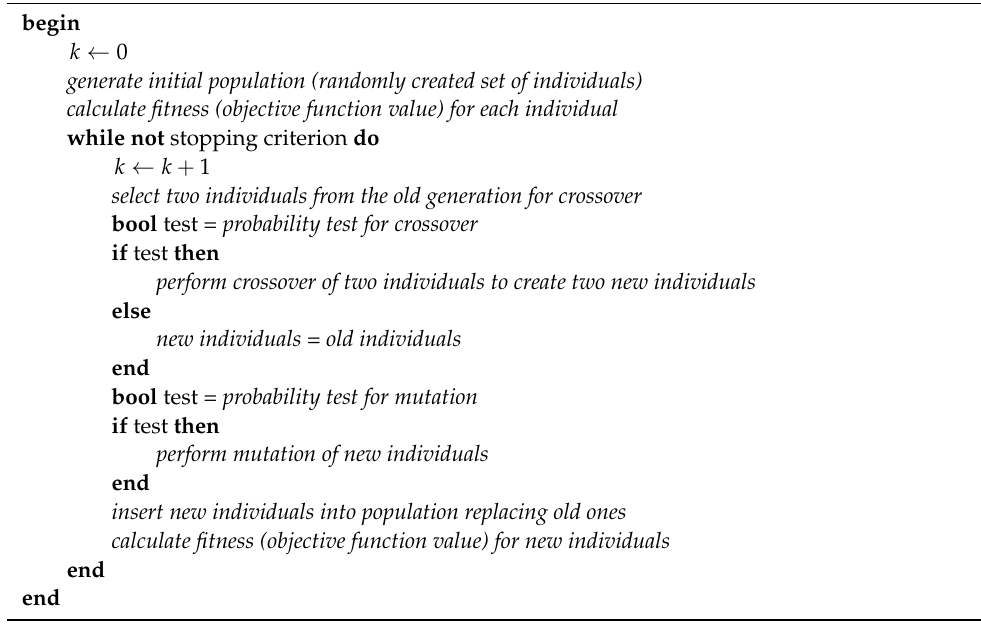
Algorithm 1: Pseudocode of genetic